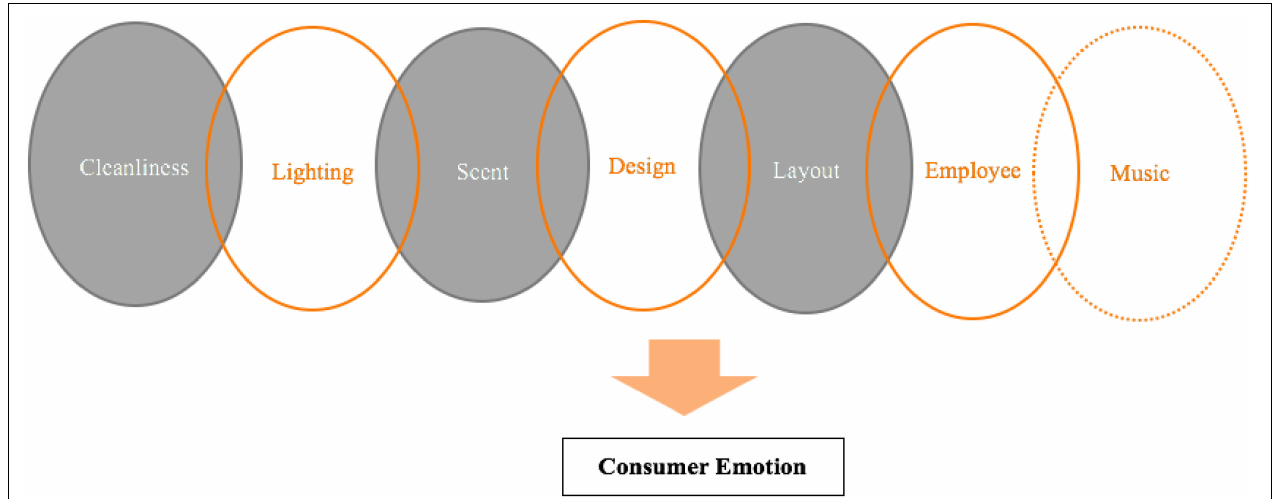
FIGURE 2 | Strong store environmental components predicting consumer emotion (fsQCA